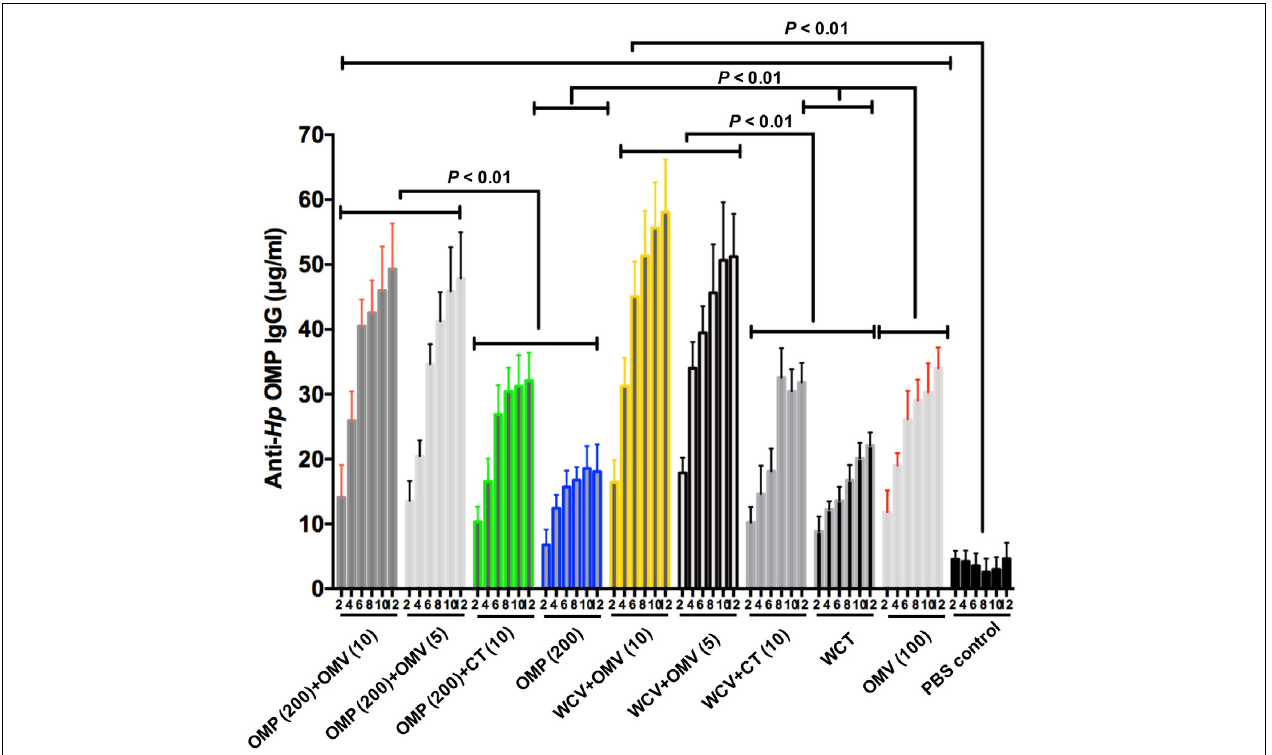
FIGURE 2 | Concentrations of anti- Hp OMP IgG within 12 weeks of the first immunization which were quantified by ELISA. Each cohort contained 18 mice. These data reflect IgG levels severally in blood specimen from immunized mice. Group immunized with OMP, WCV, or OMVs derived from H. pylori 7.13 served as negative control to discount the interference of vaccine effect. Statistical significance was assessed by two-way ANOVA test. P < 0.01 was considered as statistically significant. All the results were expressed as means ± SD per